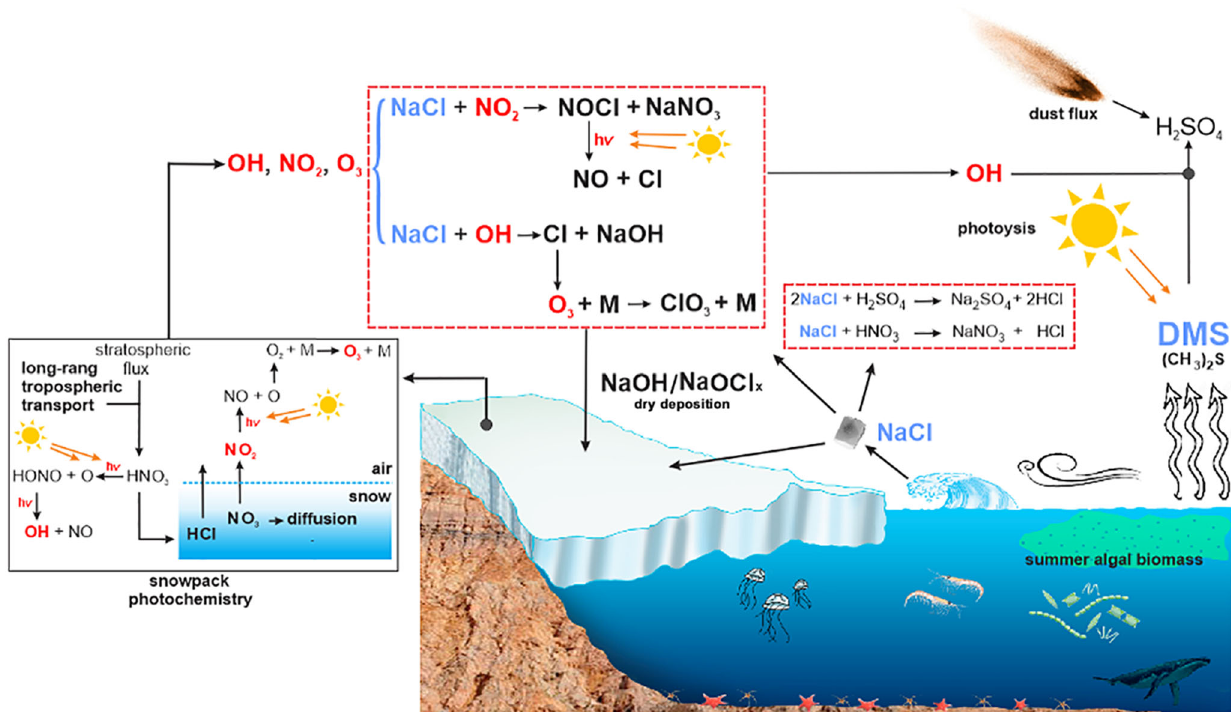
Fig. 4 Sea salt transformation in the troposphere. Schematic diagram illustrating possible chemical pathways to produce tropospheric chlorine-rich species in